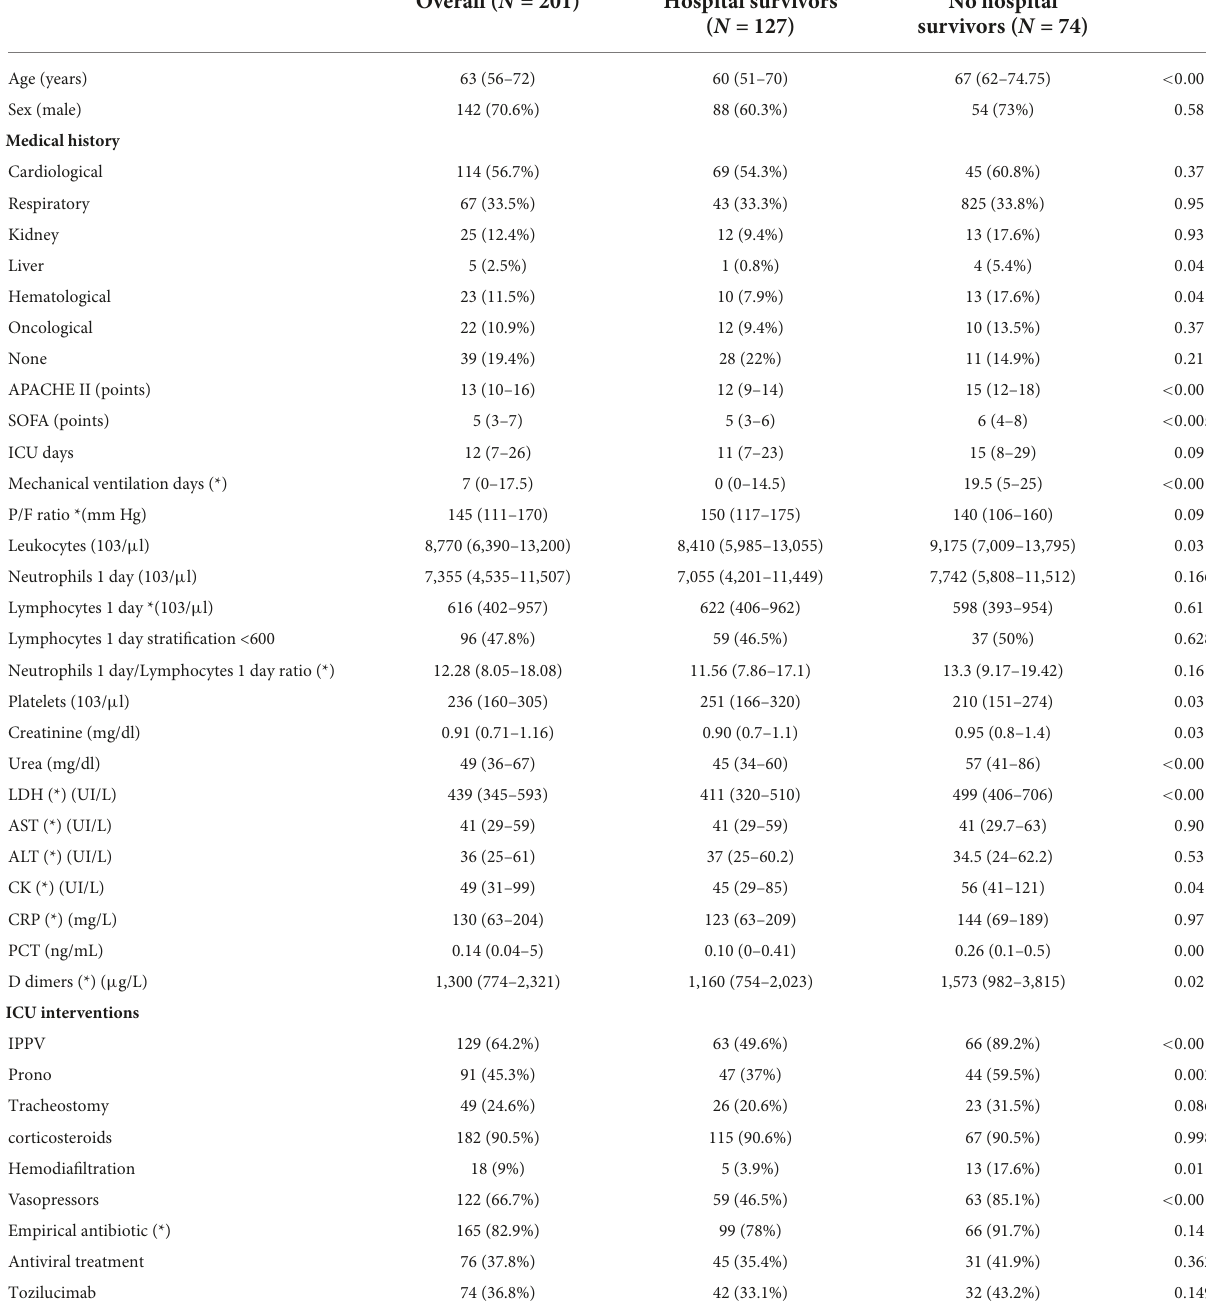
TABLE 1 Patients characteristic at ICU admission and ICU